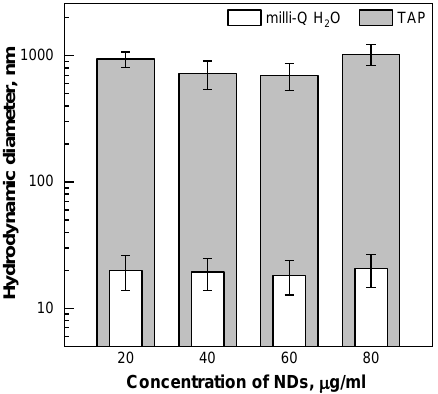
Figure 2. hNDs size distribution (hydrodynamic diameter) as a function of particle concentration in milli-Q water (white bars) and in TAP medium (grey bars). For clarity, the data are visualised on a logarithmic y -scale. Average values of 5 independent measurements (±SD, n = 5).